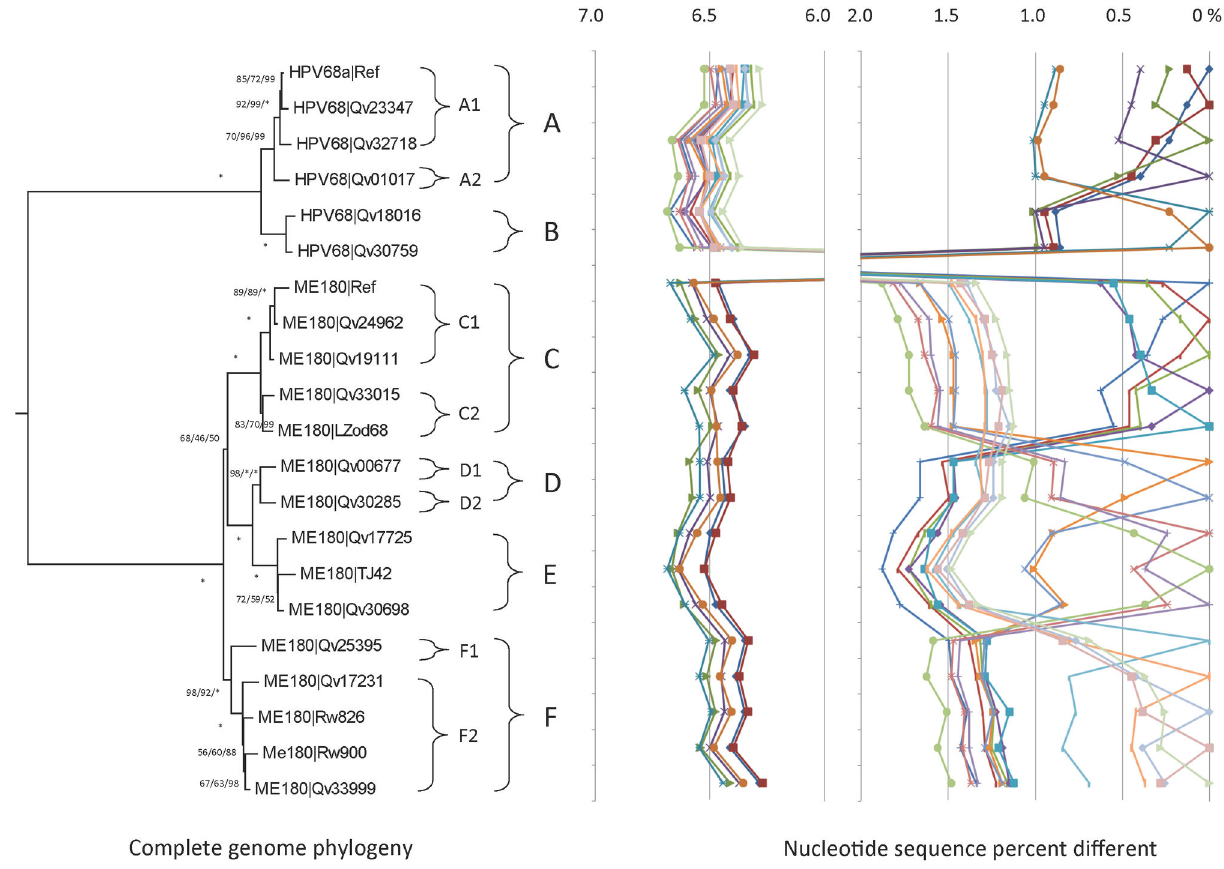
Figure 6. HPV68 variant tree topology and pairwise comparisons of individual complete genomes. The phylogenetic tree was constructed as described in Figure 2. Distinct variant lineages and sublineages were determined as described in Figure 2. The percent nucleotide sequence differences are shown in the panel to the right of the phylogenetic tree as described in Figure